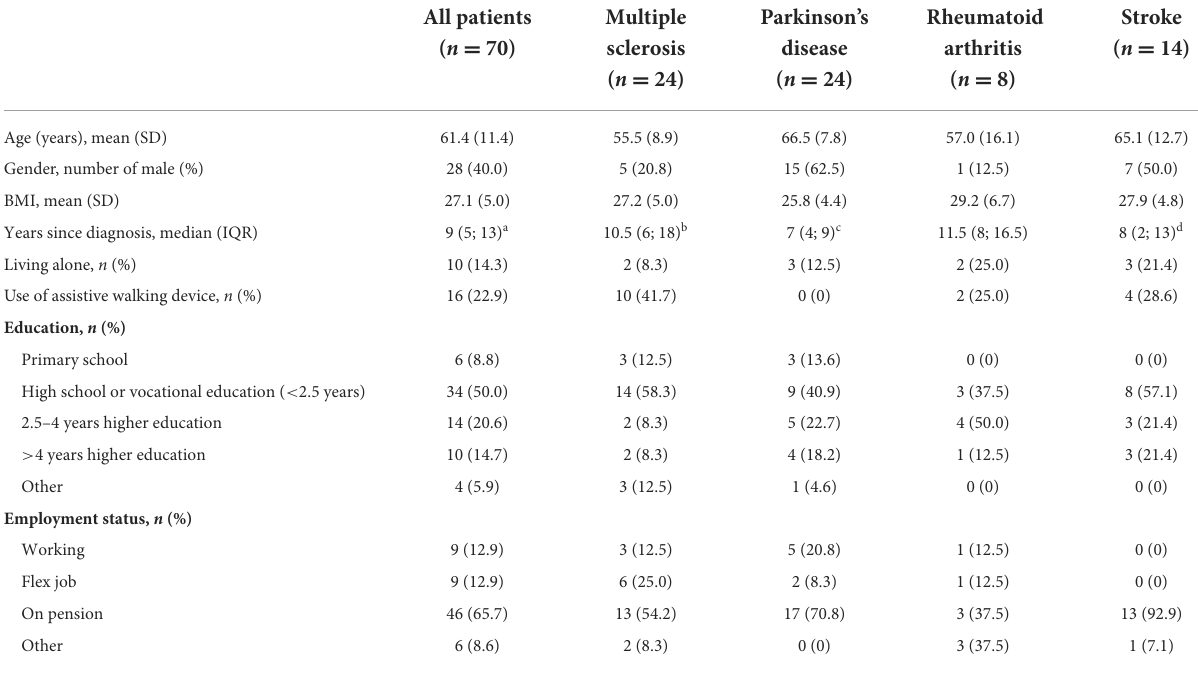
TABLE 1 Baseline